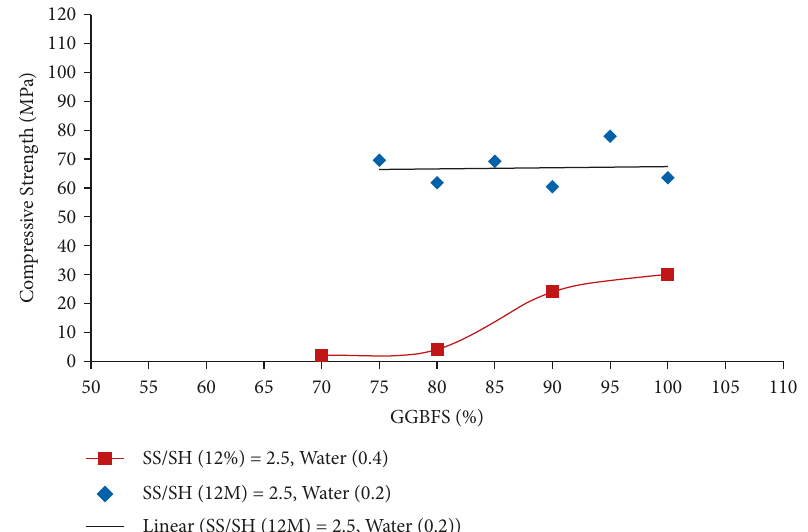
Figure 6: Boosting the mixture ratio after 7 curing days without RH.